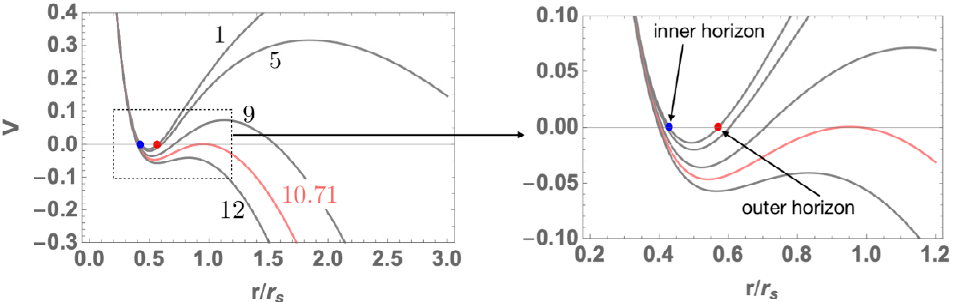
Figure 6 . Plots of the e(cid:11)ective potential with M + =M Pl = 1 ; 5 ; 9 ; 10 : 71 (critical mass), and 12. We here take a = 0 : 99 GM , H = 5 (cid:2) 10 (cid:0) 3 M Pl and (cid:6) = 5 (cid:2) 10 (cid:0) 4 M Pl . The blue and red points represent the position of the inner and outer horizons, respectively. The pink lines show the e(cid:11)ective potential with the critical mass M + = M C .